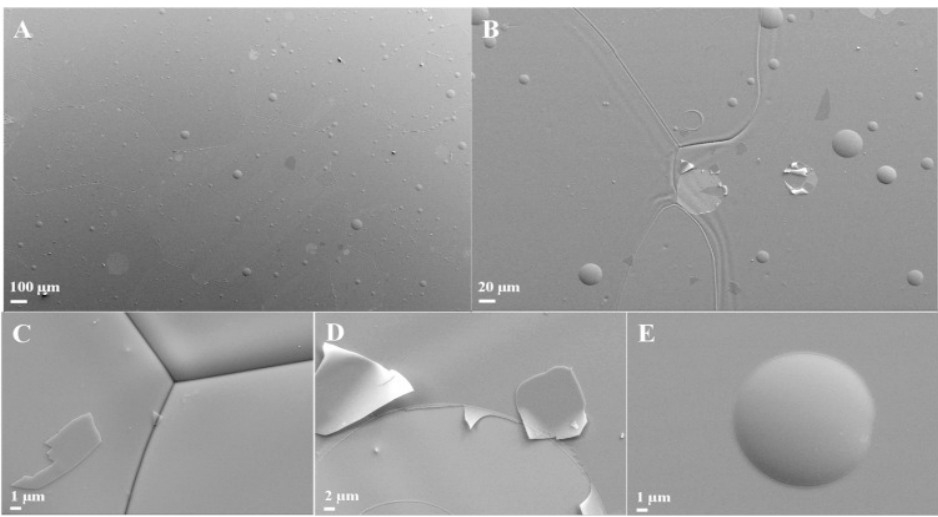
Figure 14. FEG ‐ SEM images for the pristine 50 ‐ nm atomic layer deposition (ALD) alumina ‐ coated sample prepared on the annealed copper substrate